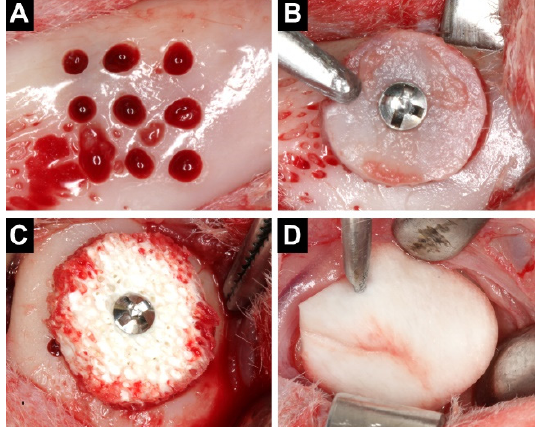
Figure 1. Surgical procedures. ( A ) Nine equidistant monocortical perforations at the recipient site. ( B ) Autogenous bone block fixed to the angle of the mandible. ( C ) Equine xenogenous bone block fixed at the contralateral recipient site. ( D ) Bovine pericardium membrane to cover the grafts.